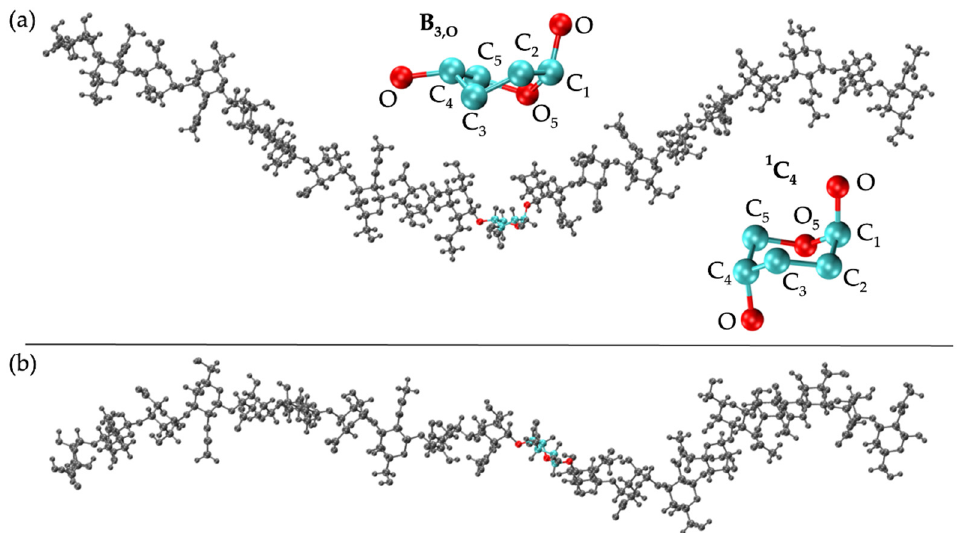
Figure 10. MD-generated nonsulfated dermatan conformations: ( a ) 20-mer with a B 3,O IdoA conformer (ring atoms in cyan; linkage atoms in red) and B 3,O IdoA and 1 C 4 IdoA monosaccharide conformations (endocyclic ring atoms and linker oxygen atoms only); ( b ) 20-mer with a 2 S O IdoA conformer highlighted (ring atoms in cyan; linkage atoms in red; 2 S O α -IdoA is identical to 2 S O β -GlcA in Figure 4c); in both 20-mer conformations, all IdoA monosaccharides in gray are in 1 C 4 and all GalNAc monosaccharides are in 4 C 1 .